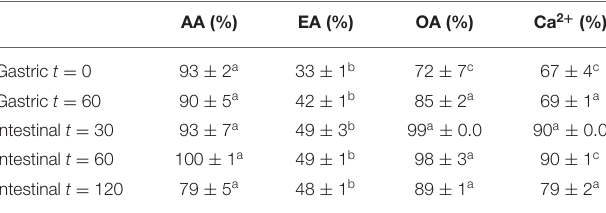
TABLE 1 | Bioaccessibility of AA, EA, OA, and calcium (Ca 2 + ) released from the T. ferdinandiana fruit matrix. AA (%) EA (%) OA